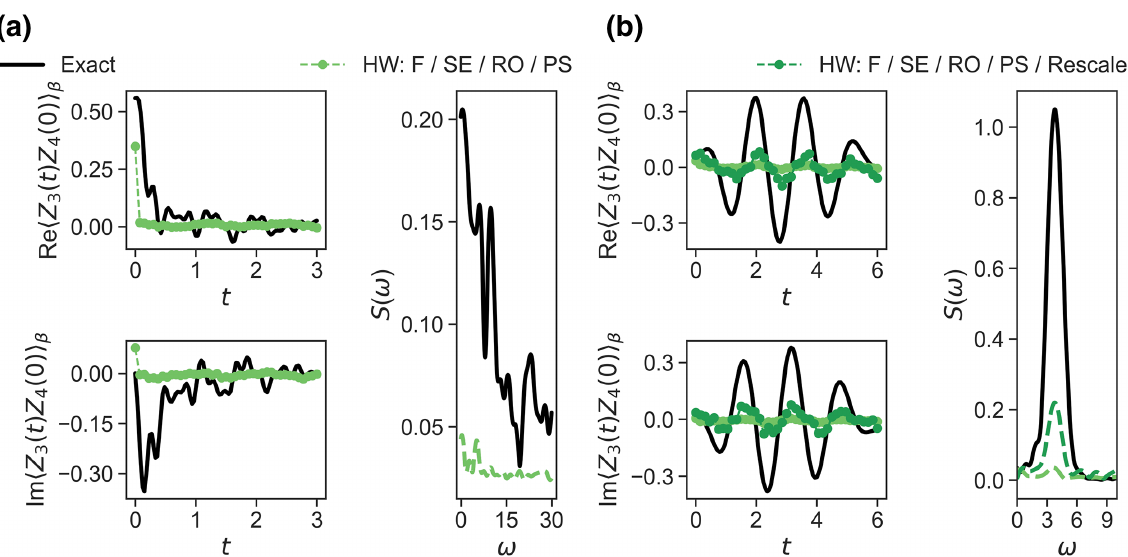
FIG. 5. (a) The dynamical correlation function (cid:2) Z 3 ( t ) Z 4 ( 0 ) (cid:3) β and its transform S (ω) at β = 1 for the α -RuCl 3 ten-site model. Even after all error-mitigation strategies (light green), the data in this case are too degraded to rescale. (b) The dynamical correlation function (cid:2) Z 3 ( t ) Z 4 ( 0 ) (cid:3) β and its transform S (ω) at β = 1 for strongly anisotropic Kitaev-Heisenberg model parameters: J = 0.4, K x = = K = K x − 8, and K . Reasonable frequencies are obtained after rescaling (dark green). Error-mitigation acronyms: SE, spin echoes; y z 6 F, Floquet calibration; RO, readout-error mitigation; PS, postselection; HW, hardware. where (cid:2) A (cid:3) ideal